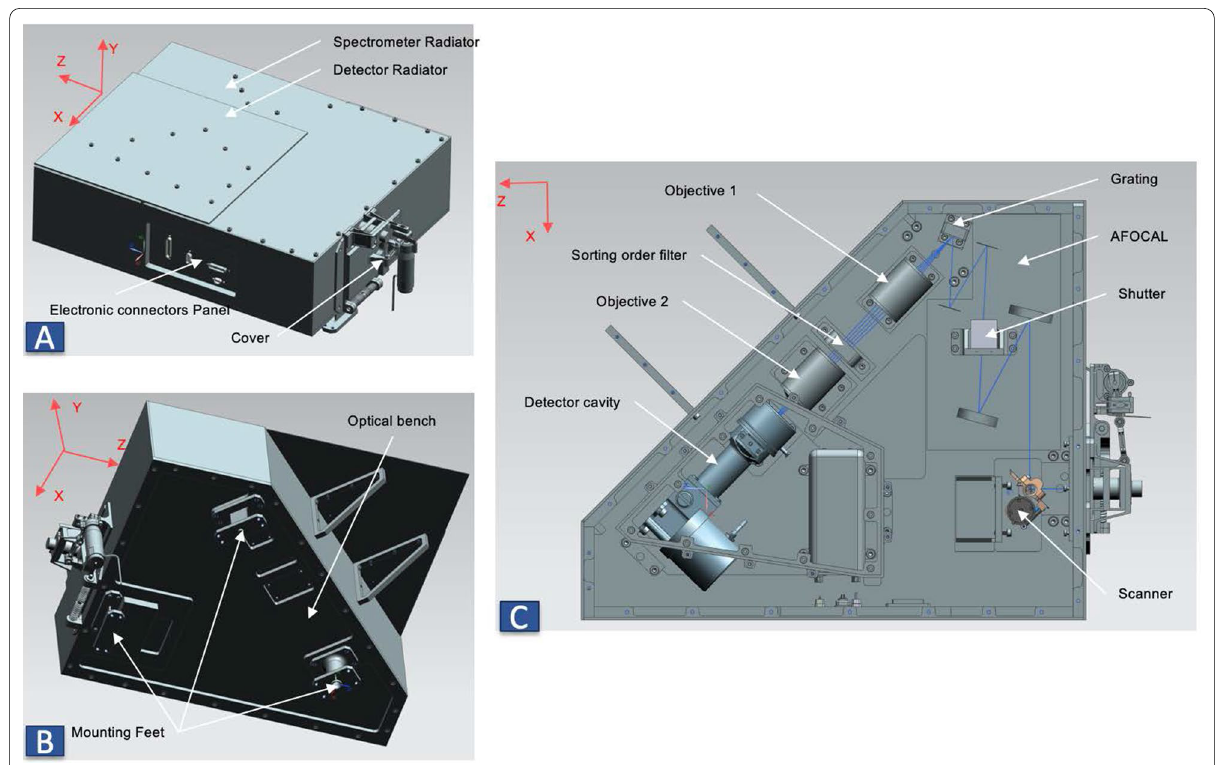
Fig. 8 MIRS OBOX external interface ( A and B ) and MIRS optical layout ( C )